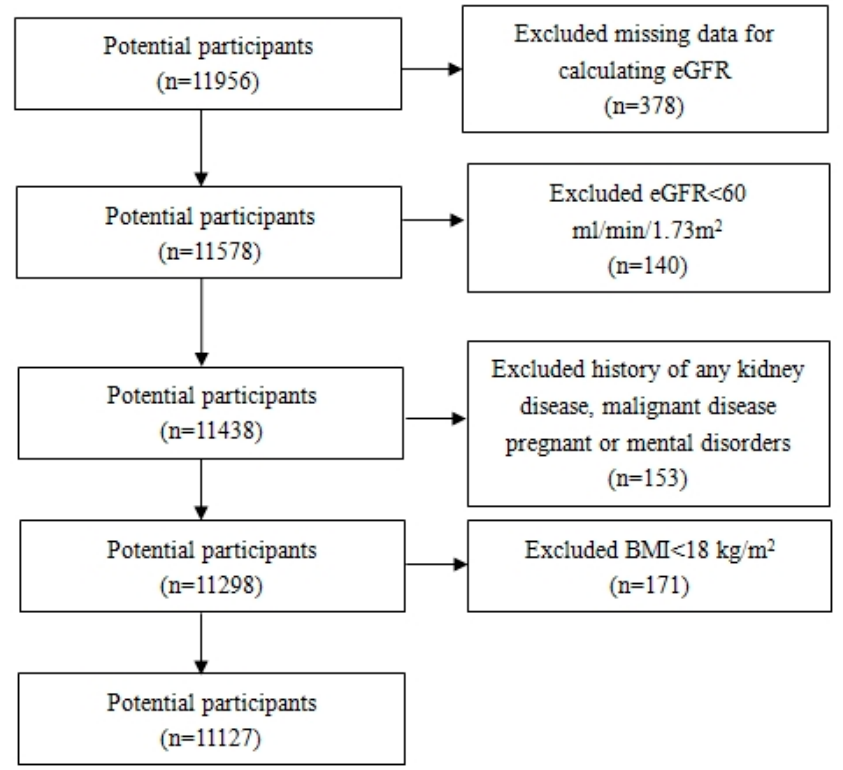
Figure 1. Flow diagram for study design showing inclusion of participant in analyses. BMI: body mass index; eGFR: estimated glomerular filtration rate.